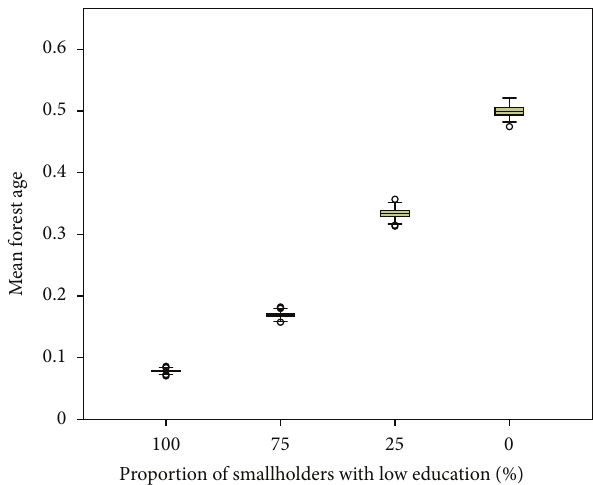
Figure 5: Land use and land cover change clustering (measured using Moran’s I for spatial autocorrelation at the landscape scale) increases significantly with an increase in social influence.